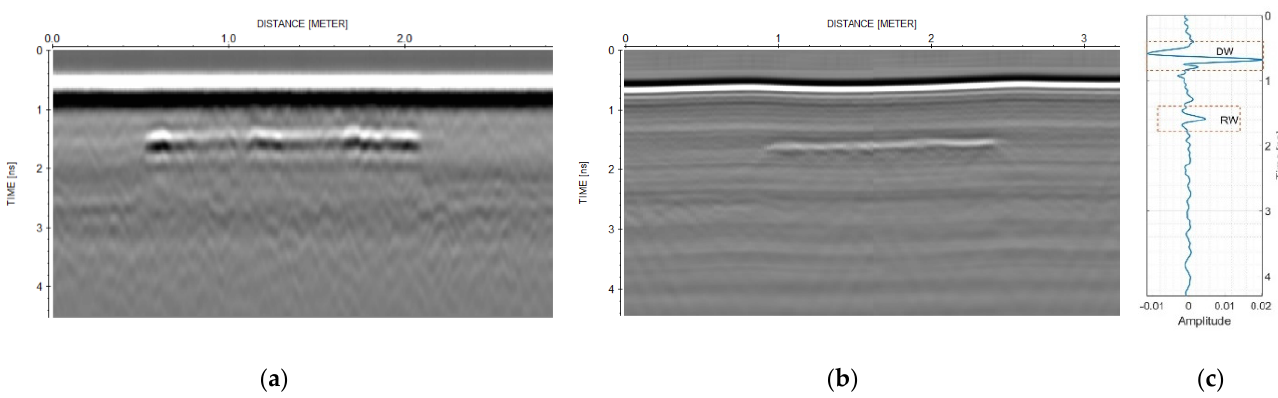
Figure 5. Examples of B-scans performed at 720 K loadings on the defect I11 (sand) by ( a ) the ground-coupled 2.6 GHz impulse system and ( b ) the air-coupled 5 GHz stepped-frequency system. ( c ) A-scan extracted from Figure 5b on the defect and showing the direct wave (DW) and the reflected wave (RW).